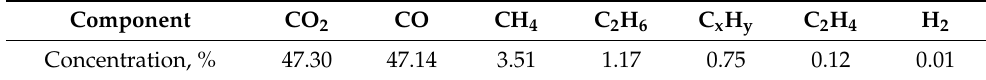
Table 3. Pyro—gas composition.